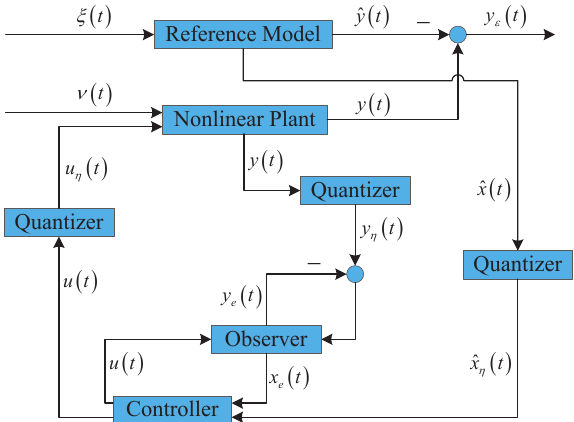
Figure 1. The block diagram of nonlinear networked